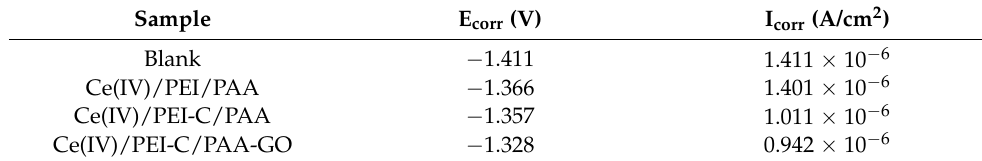
Table 2. The sample fitting results of the polarization curves.